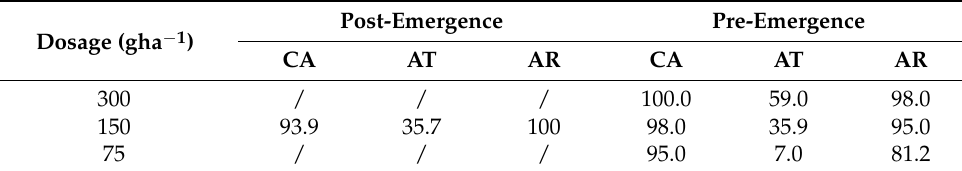
Table 5. Herbicidal activities of compound V-8